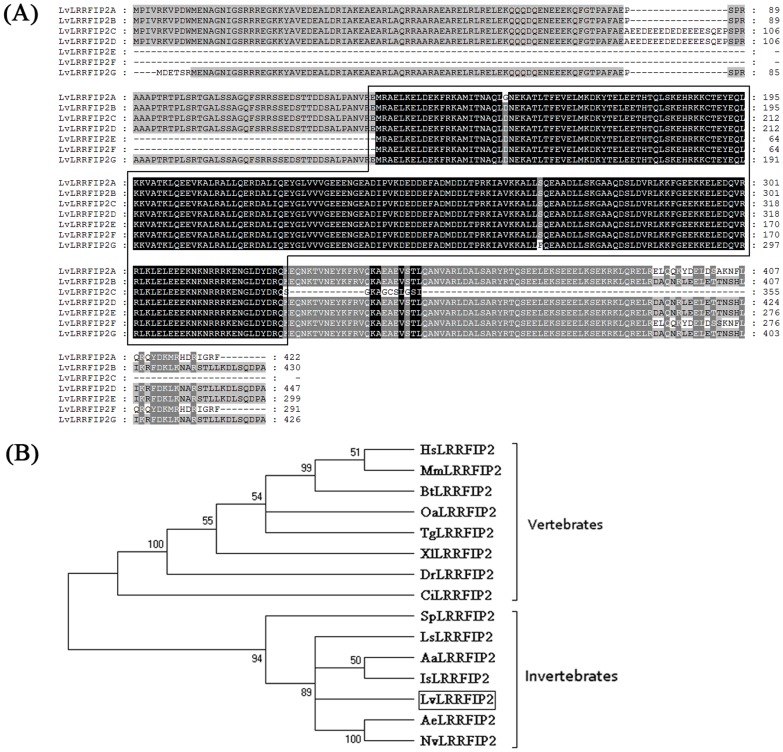
Multiple sequence alignment of LvLRRFIP2s in Litopenaeus vannamei and phylogenetic analysis of LRRFIP2 proteins from various species.(A) Multiple sequence alignment of LvLRRFIP2s in Litopenaeus vannamei. The identical amino acid residues shaded in black and the similar residues in gray. The DUF2051 domains are boxed. (B) Phylogenetic analysis of LRRFIP2 proteins. A rooted tree was constructed via the neighbor-joining method and was bootstrapped 1000 times using MEGA 4.0 (http://www.megasoftware.net/index.html). LvLRRFIP2 is boxed. LvLRRFIP2, L. vannamei LRRFIP2D (Accession No. JX840476); AeLRRFIP2, Acromyrmex echinatior LRRFIP2 (Accession No. EGI63253); NvLRRFIP2, Nasonia vitripennis LRRFIP2 (Accession No. XP_001608049); LsLRRFIP2; Lepeophtheirus salmonis LRRFIP2 (Accession No. ACO11882); AaLRRFIP2, Aedes aegypti LRRFIP2 (Accession No. XP_001654827); SpLRRFIP2, Strongylocentrotus purpuratus LRRFIP2 (Accession No. XP_782587); IsLRRFIP2, Ixodes scapularis LRRFIP2 (Accession No. XP_002410685); CiLRRFIP2, Ciona intestinalis LRRFIP2 (Accession No. XP_002130672); HsLRRFIP2, Homo sapiens LRRFIP2 (Accession No.NP_060194); BtLRRFIP2, Bos taurus LRRFIP2 (Accession No. NP_001033159); MmLRRFIP2, Mus musculus LRRFIP2 (Accession No. NP_082018); TgLRRFIP2, Taeniopygia guttata LRRFIP2 (Accession No. XP_002198991); DrLRRFIP2, Danio rerio LRRFIP2 (Accession No.NP_955773); XlLRRFIP2, Xenopus laevis LRRFIP2 (Accession No. NP_001085821); OaLRRFIP2, Ornithorhynchus anatinus LRRFIP2 (Accession No. XP_003430994).